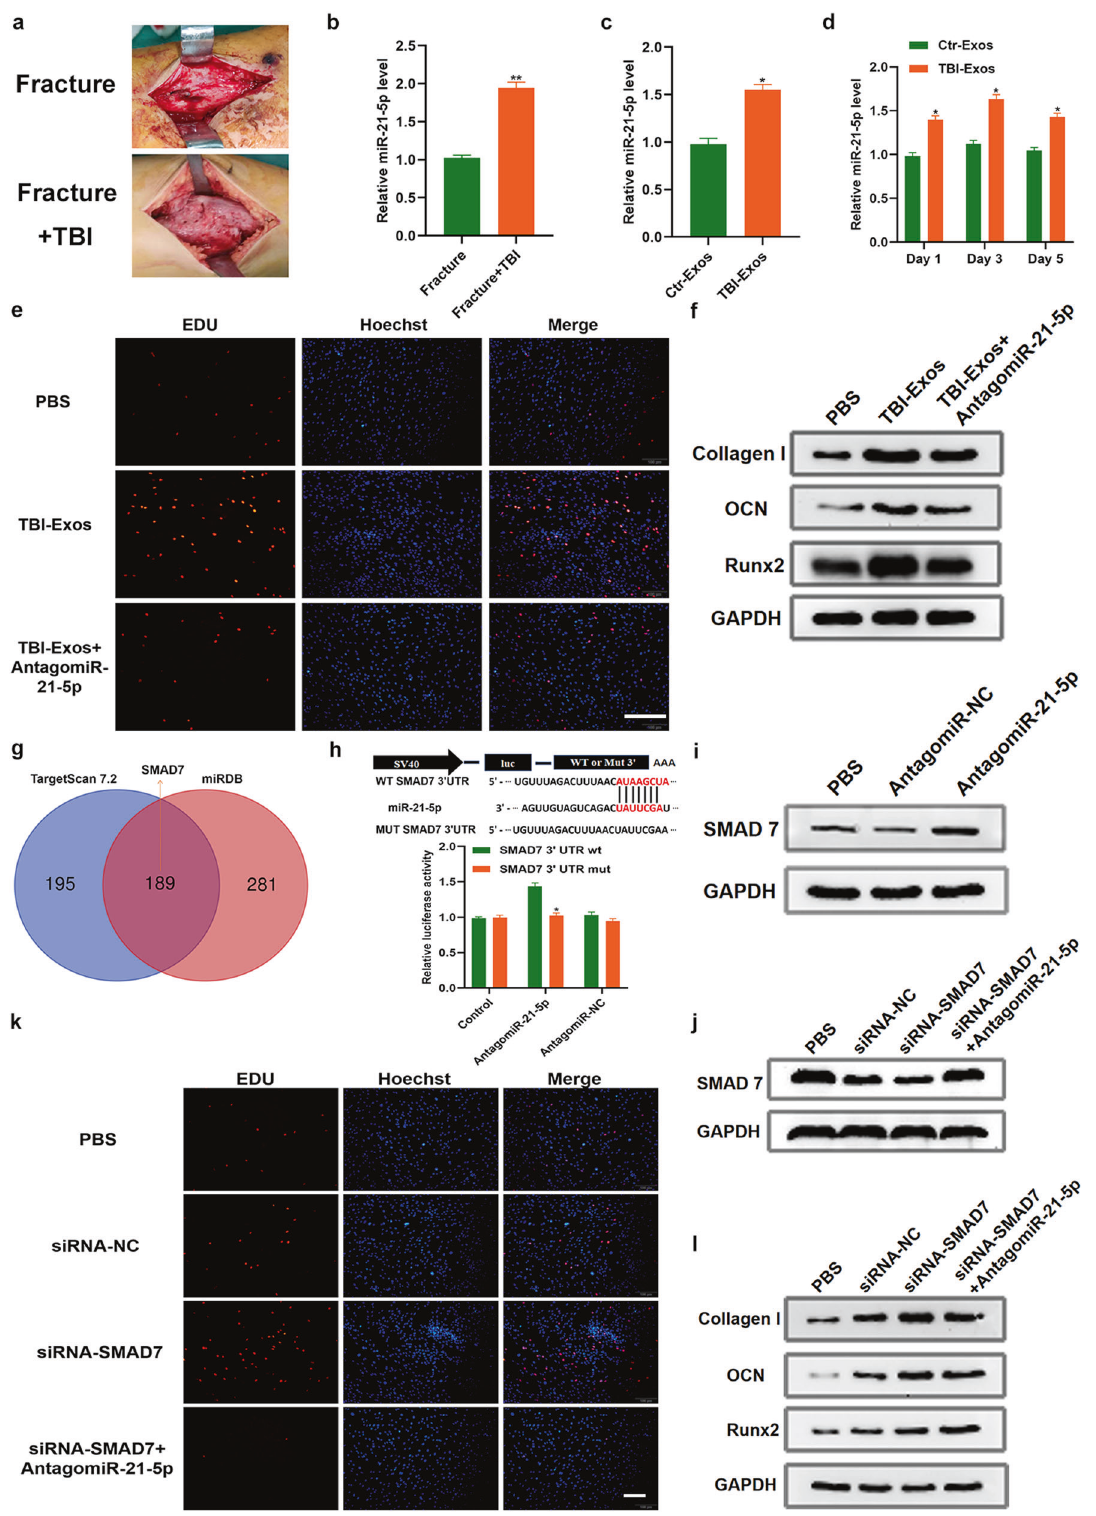
Fig. 4 The underlying mechanism of TBI in the regulation of fracture healing. a The calluses at the fracture site were more visible in the fracture + TBI group than in the fracture group. b , c The relative miR-21-5 p level was measured in both serum and Exos using qRT ‒ PCR analysis. d The miR-21-5 p expression of hMSCs in different groups was measured by qRT ‒ PCR analysis. e An EdU assay was performed to assess cell proliferation in the different groups. f Western blotting was used to detect osteogenic-related proteins in the different groups. g The potential targets of miR-21-5 p were identi fi ed using online prediction tools. h A luciferase reporter assay was performed to test the interaction of miR-21-5 p and SMAD7 . i , j SMAD7 levels in the different groups were measured by western blotting analysis. k The EdU assay was used to evaluate hMSC proliferation. l Western blotting was used to measure the expression of osteogenic-related proteins. Data are the mean ± SD of triplicate experiments. * p < 0.05, ** p < 0.01, *** p <